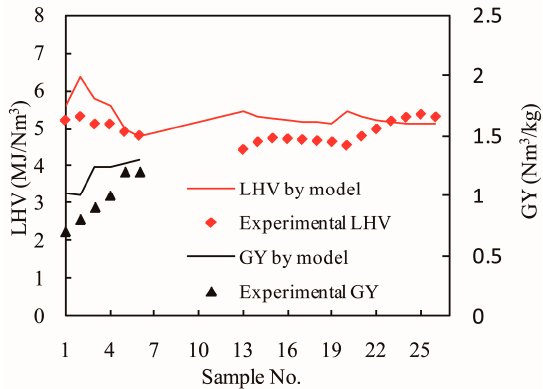
Figure 2. Comparisons between experimental data and predicted data for lower heating value (LHV) and gas yield (GY).